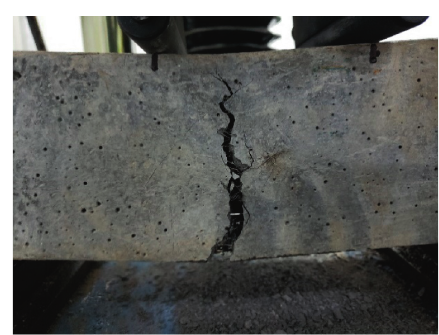
Figure 9: Flexural test results.